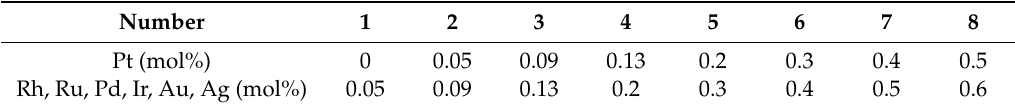
Table 2. The proportion of added